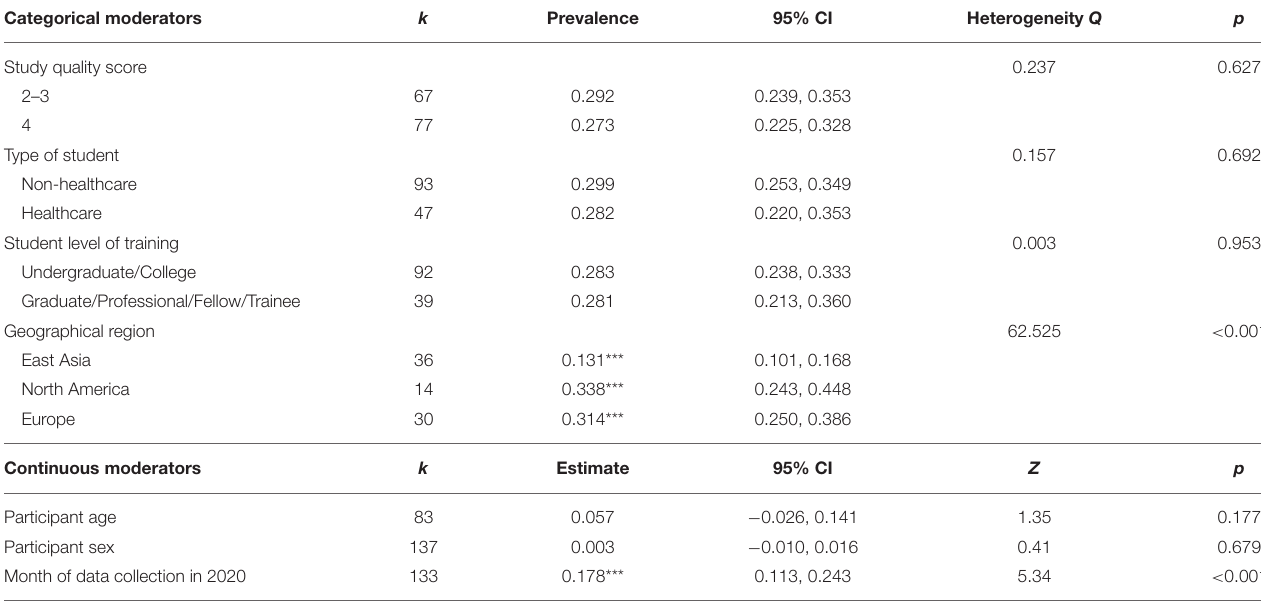
TABLE 3 | Results of moderator analyses for the prevalence of anxiety symptoms in post-secondary students during COVID-19. Categorical